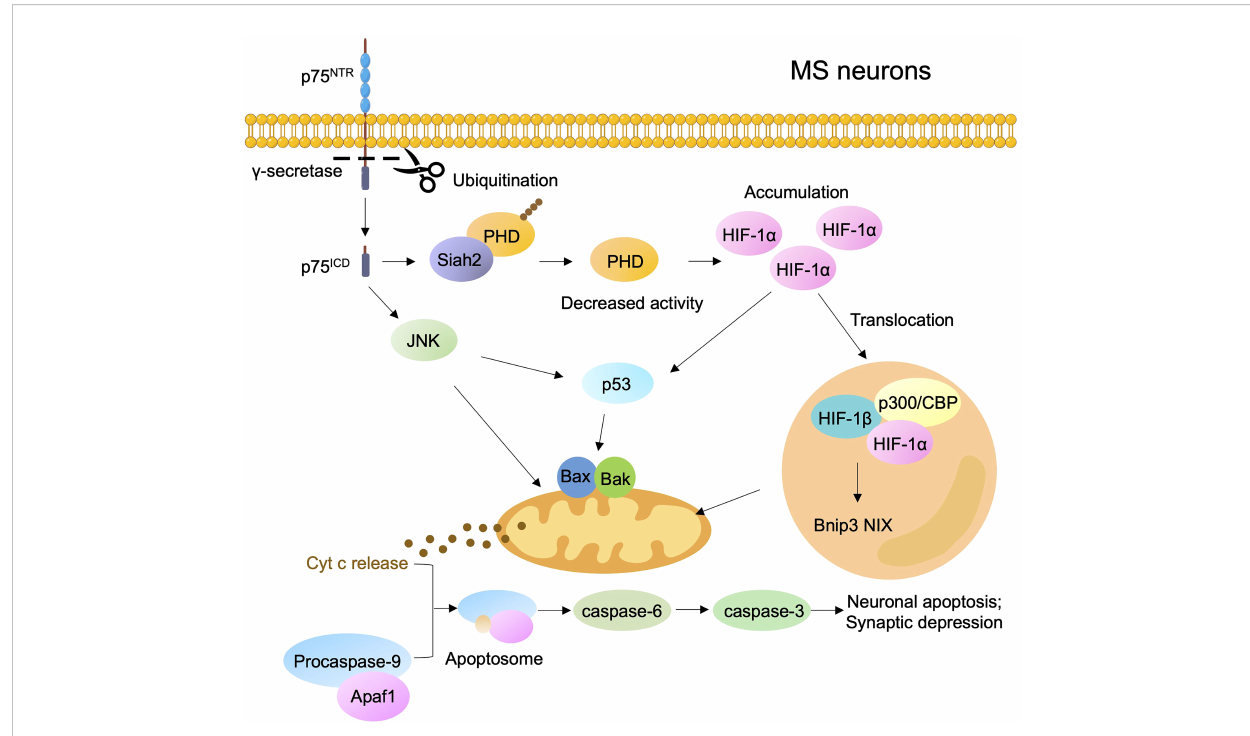
FIGURE 3 P75 NTR activates signaling pathways regulating neuronal death in MS during hypoxia. Hypoxia increases the g -secretase of p75 NTR to release p75 ICD and then increases Siah2, which results in the ubiquitination and degradation of prolyl hydroxylases (PHD), thereby promoting stabilization and accumulation of HIF-1 a . The pool of HIF-1 a triggers mitochondrial signaling pathways to induce neuronal apoptosis by activating p53 or by up- regulating the proapoptotic gene